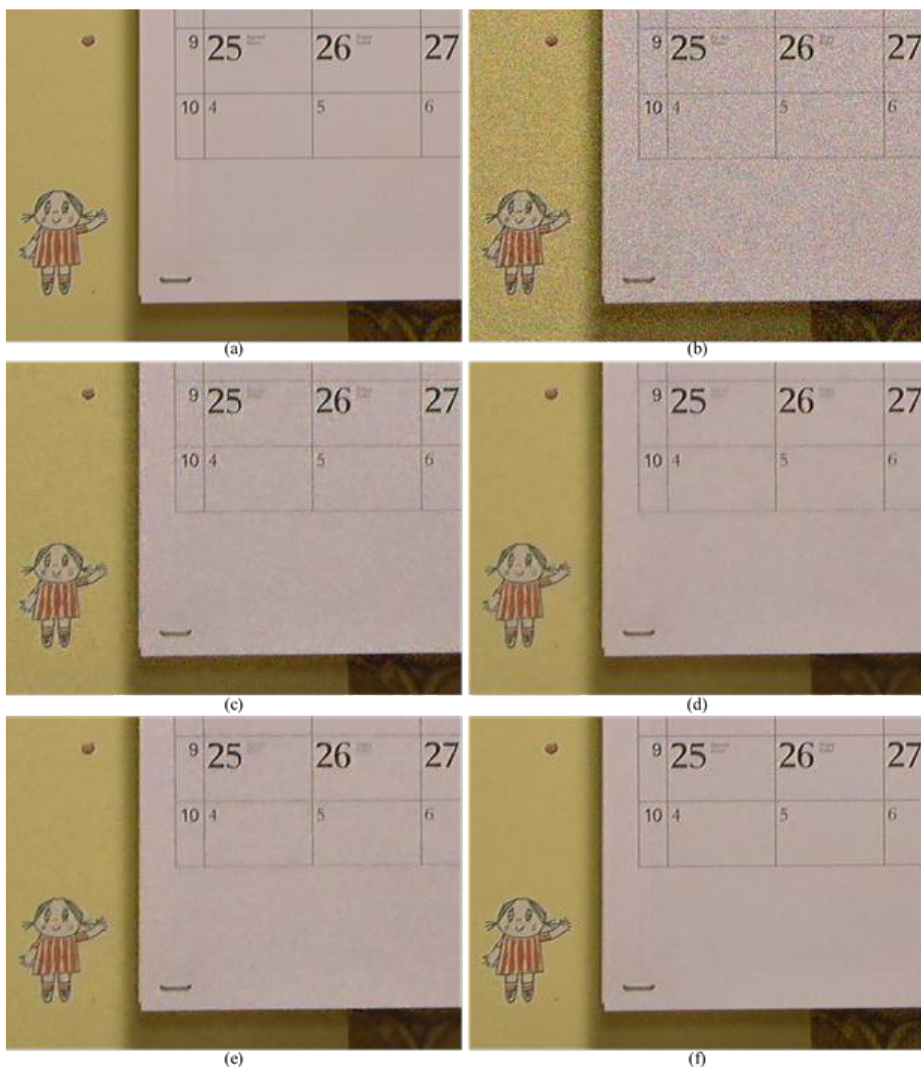
Figure 12. Partially magnified the Calendar sequence. ( a ) Original image; ( b ) Color demosaiced image obtained by [15] for noisy image with σ = 10 of Bayer pattern; ( c ) Denoised image by method [31] with demosaicing of [15]; ( d ) Denoised image by method [9] with demosaicing of [15]; ( e ) Denoised image by method [32]; ( f ) Denoised image by proposed method with demosaicing of [15].